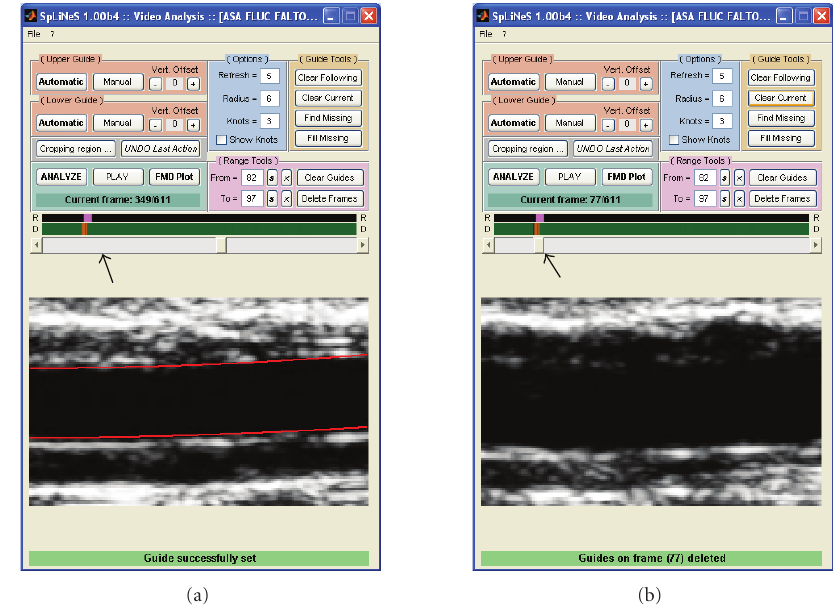
Figure 10: The first window of the software presents an “average frame” derived as an average of all frames in the video and is used to manually set the ROI. The second window requires the operator to click on two calibration marks to calibrate the images.